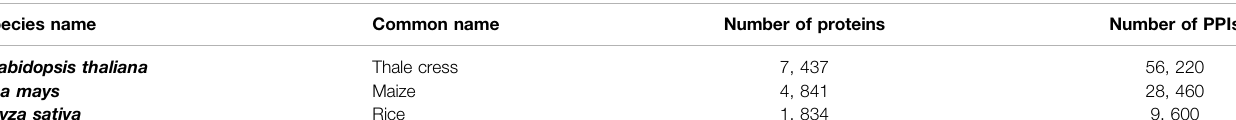
TABLE 7 | Summary of plant PPIs and proteins in different species.